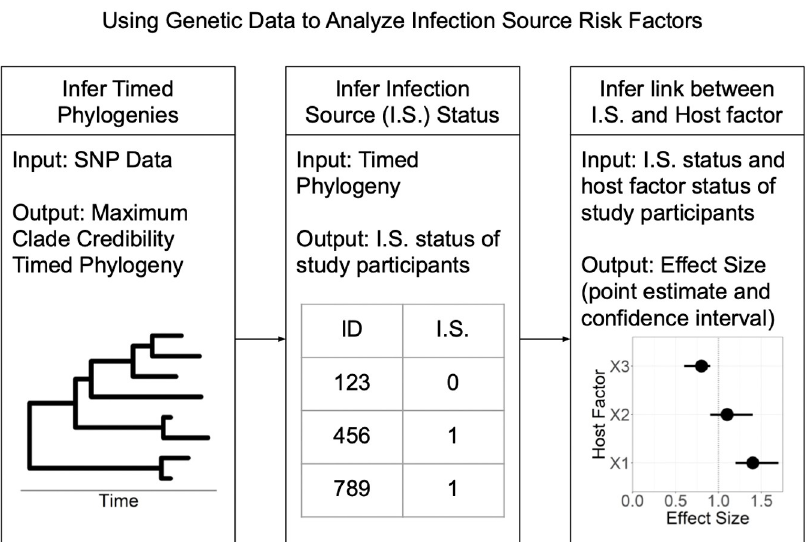
Fig 1. Visualization of statistical pipeline evaluated in this paper. Genomic data are used to construct timed phylogenetic trees, which are then used as inputs to infer transmission trees. Based on transmission trees, probability of being an infection source is derived, and then used as a response variable in an analysis of host factor